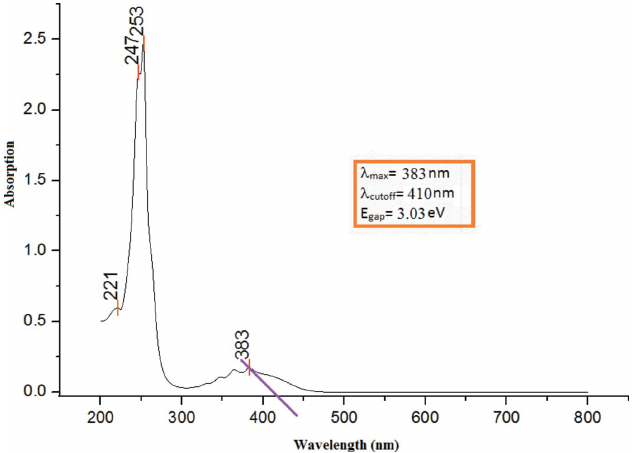
Figure 4 View of the Hirshfeld surfaces mapped over d norm for (I).